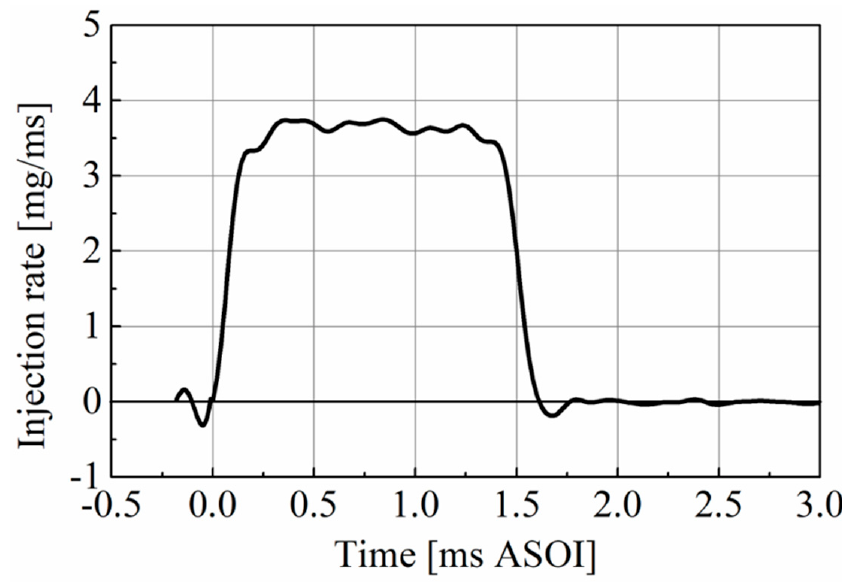
Figure 3. Temporal variation of injection rate (P inj = 100 MPa, M f = 5.0 mg).